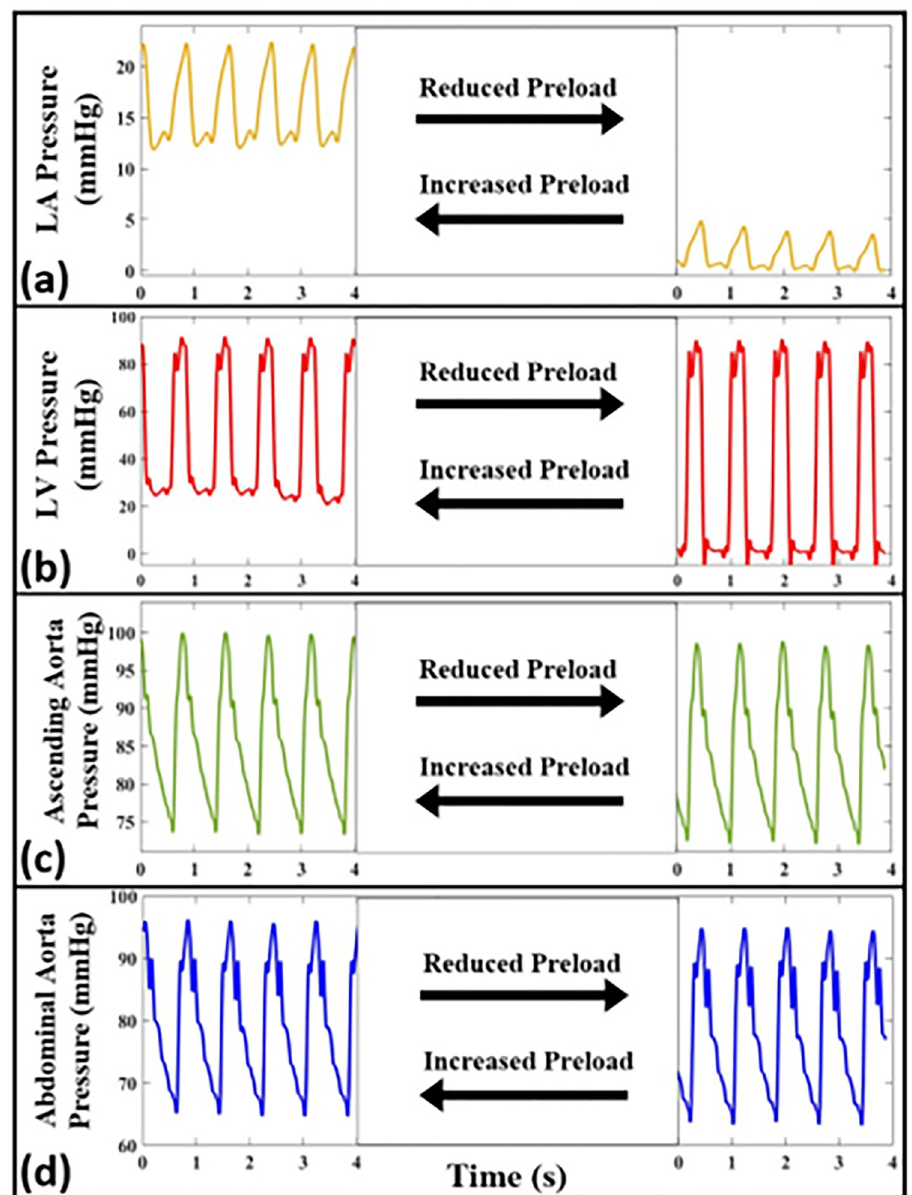
Fig 13. The measured pressure waveforms for increased and reduced preload conditions at different anatomical sites including (a) the left atrium, (b) the left ventricle, (c) the ascending aorta, and (d) the abdominal aorta. Waveforms are measured in Aorta-3 and correspond to HR = 75 bpm. The data of this figure is collected without pausing the pump to show the immediate dynamic changes of the setup (we only showed the oscillatory steady state of each phase for